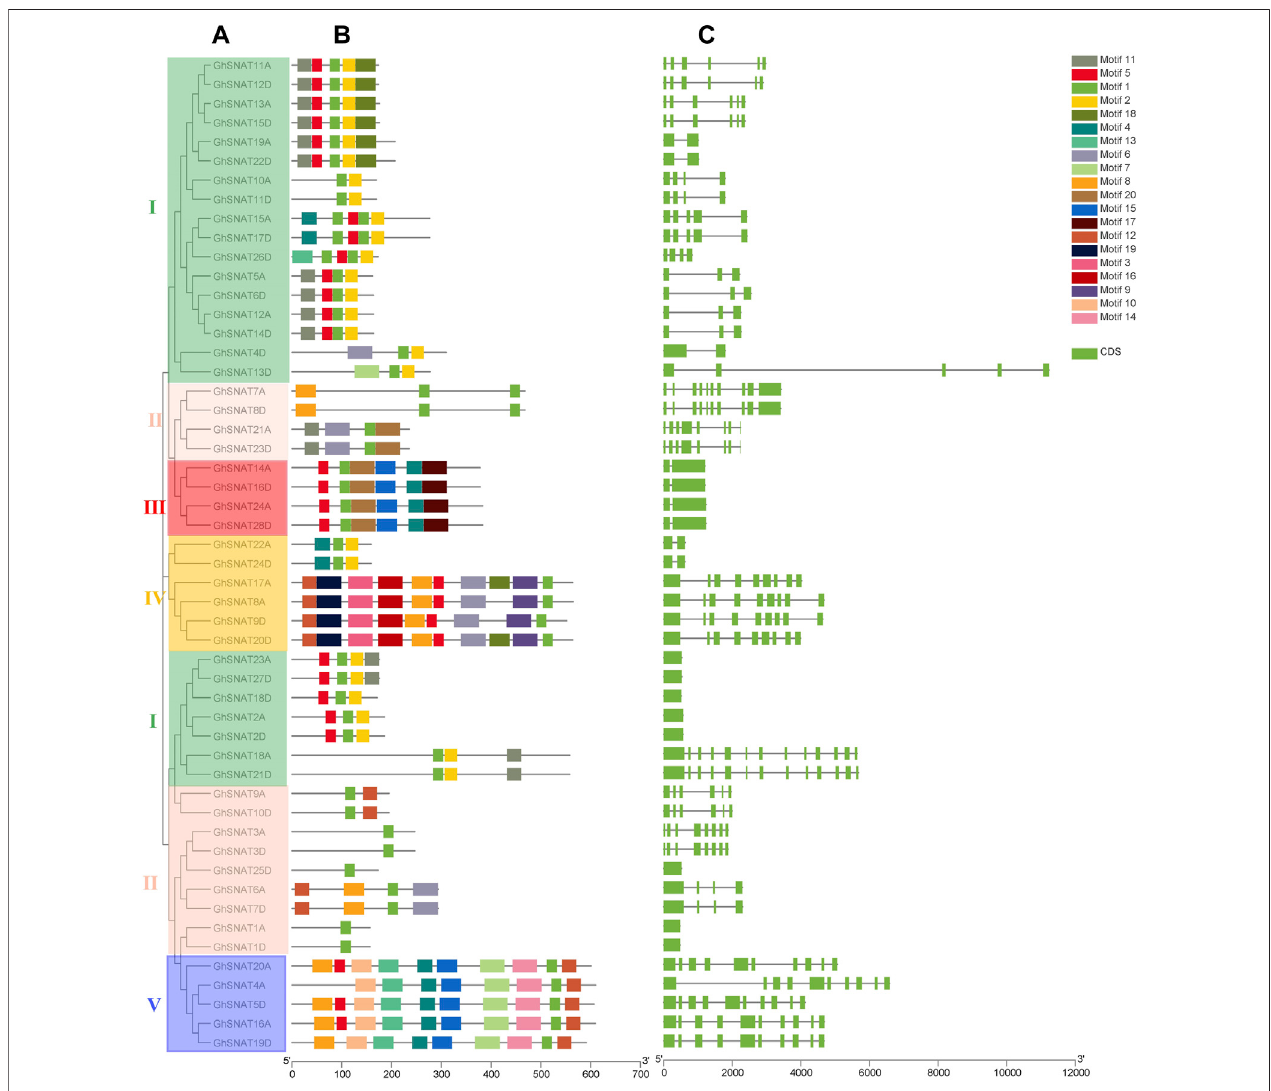
FIGURE 2 | The evolutionary relationship of GhSNATs in Gossypium hirsutum , the association analysis of motif composition and gene structure. (A) : The phylogenetic tree of GhSNAT s; (B) : The motif composition of GhSNAT s; (C) : The genetic structure of GhSNAT s.